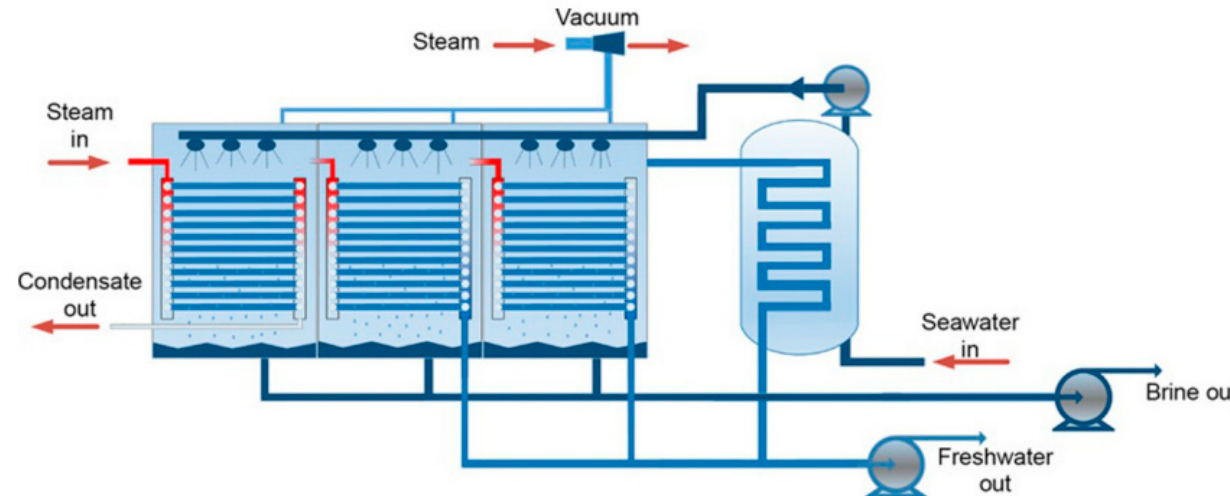
Figure 2. Schematic representation of the Multi Effect Distillation process, MED. Source: Reproduced with permission from Ref. [32].